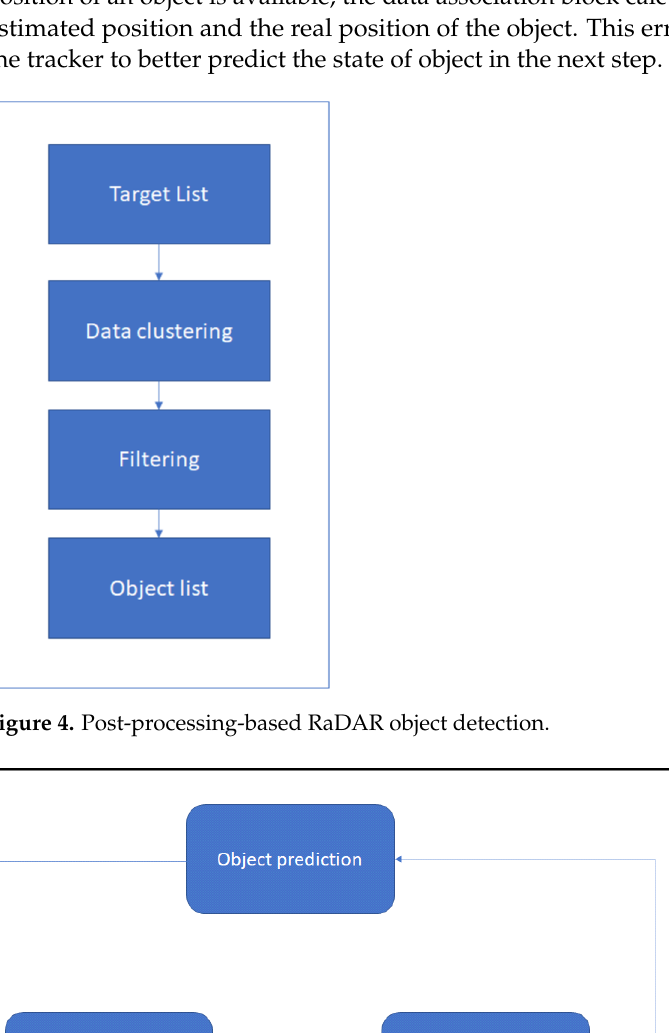
Figure 4. Post-processing-based RaDAR object detection.